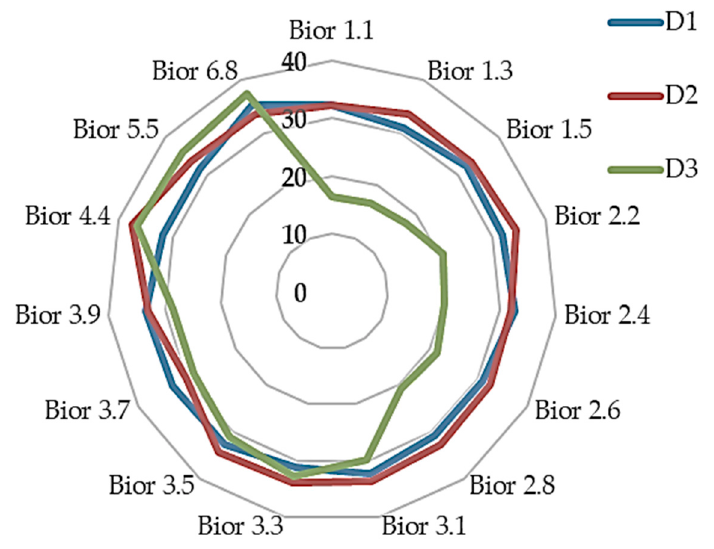
Figure 13. Showing classification accuracy comparison across various biorthogonal decomposition detail coefficient features (D1: detail coefficient sub-band1, D2: detail coefficient sub-band 2, D3: detail coefficient sub-band 3).